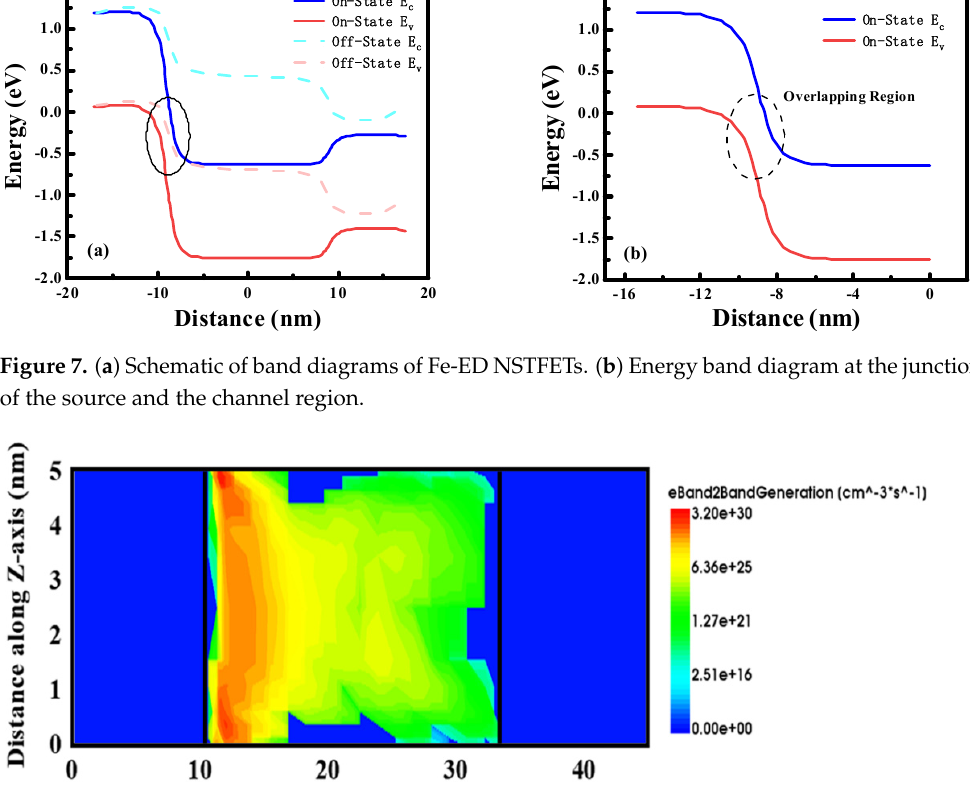
Figure 6. ( a ) I D –V G curves of Fe-ED NSTFETs and baseline devices. ( b ) I D –V D curves of Fe-ED NSTFETs.